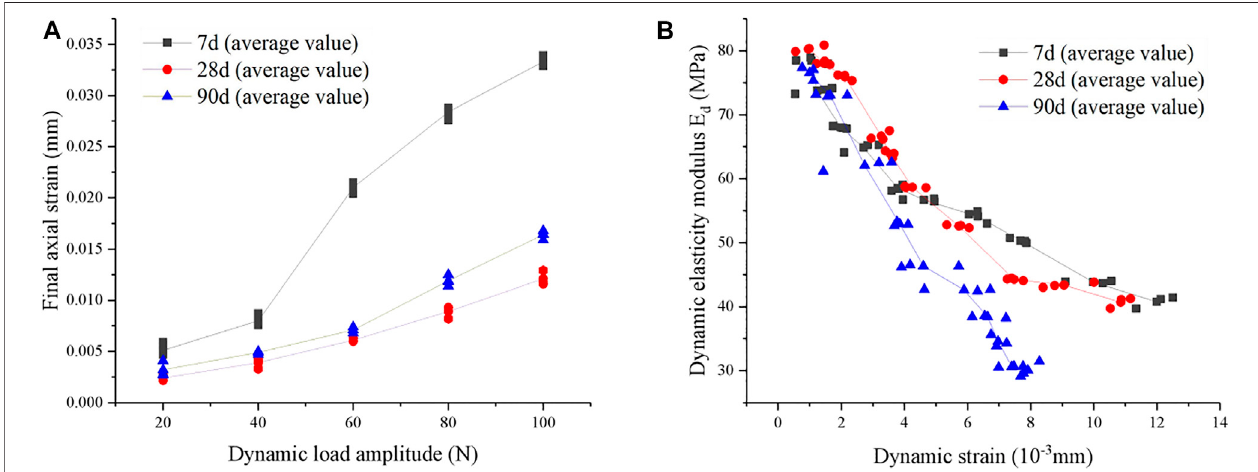
FIGURE 5 | Dynamic characteristics of solidi fi ed muddy soil at different curing ages (A) The curve between dynamic load amplitude and fi nal axial strain (B) The curve between dynamic strain and dynamic elastic modulus.